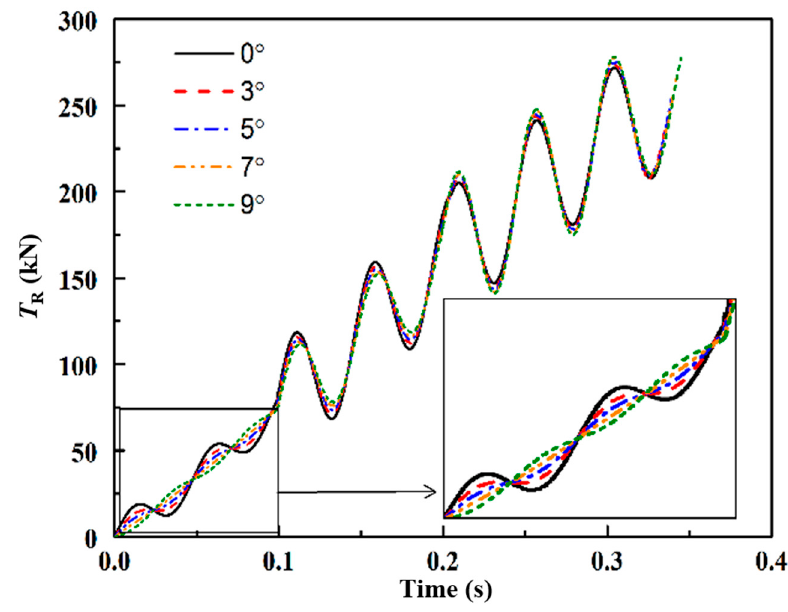
Figure 11. Starboard tension during kink-wave period.